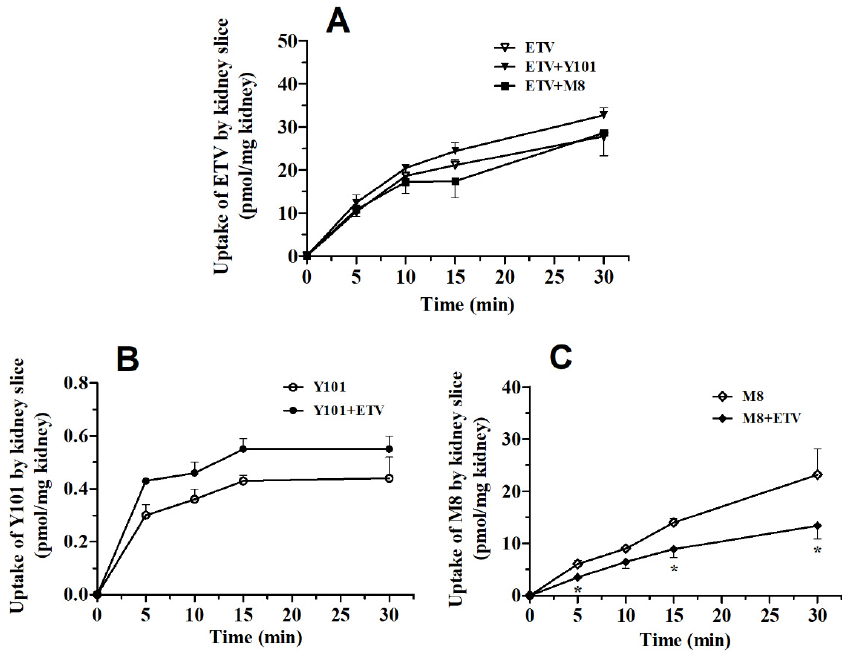
Figure 8. Time-dependent uptake of ETV (10 µM, A ), Y101 (2.0 µM, B ) and M8 (5.0 µM, C ) in kidney kidney slices (*, p < 0.05). Data are expressed as mean ± SD, n = slices (*, p ˂ 0.05). Data are expressed as mean ± SD, n = 3.